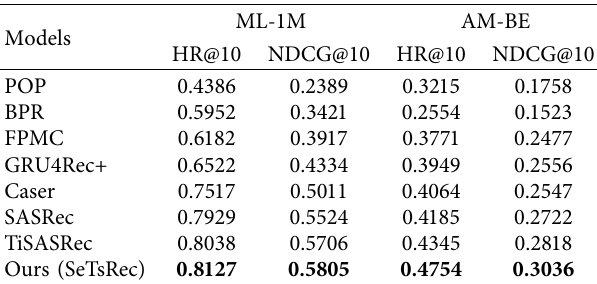
Table 3: The experimental